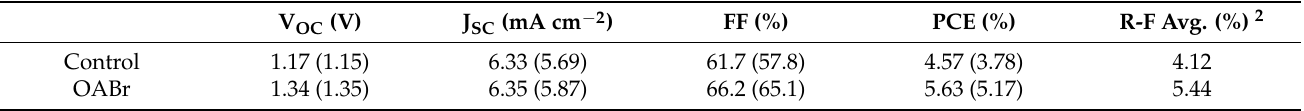
Figure 2. ( a ) J–V characteristics of control and OABr-treated CsPbBr 3 PPVs under AM 1.5 G illumination (100 mW cm − 2 ). Solid and dashed lines are the data measured in reverse and forward scans, respectively. ( b ) EQE spectra, ( c ) light intensity dependent V OC and J SC trend and ( d ) dark J–V characteristics data of control and OABr-passivated CsPbBr 3 PPVs. Table 1. Photovoltaic parameters of CsPbBr 3 PPVs with and without surface treatment using OABr in reverse scan 1 .